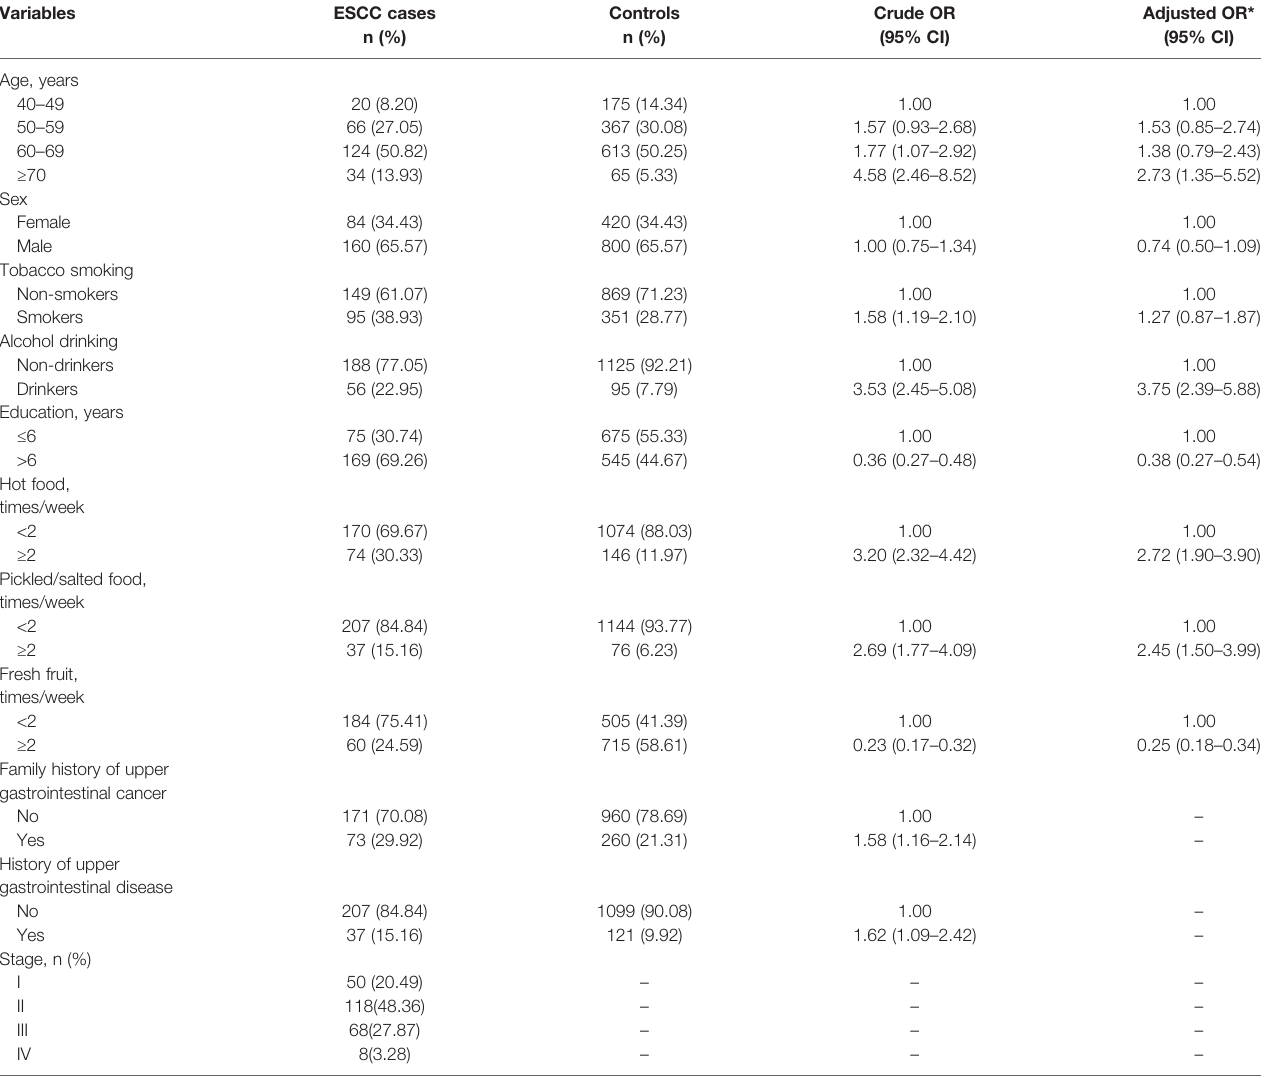
TABLE 1 | Characteristics of participants and estimated ORs from the relative risk